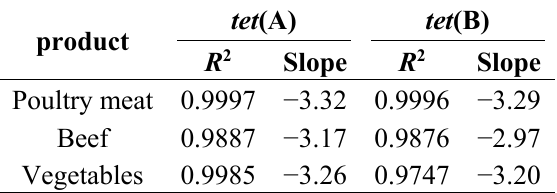
Table 1. Values of square regression coefficient (R2) and slope of the standard